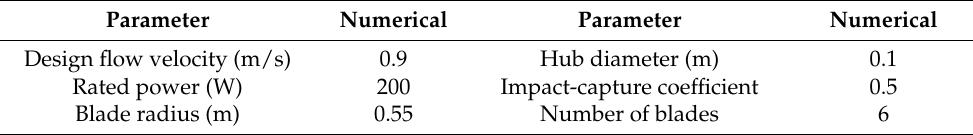
Table 1. Basic design parameters of the hydraulic